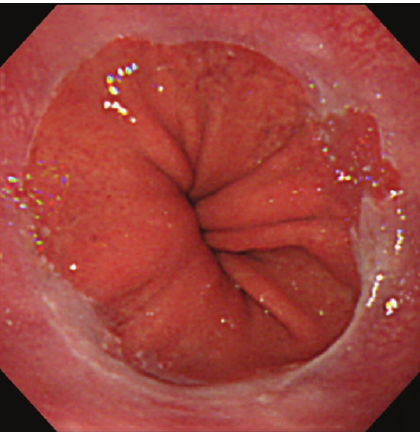
Figure 3: Endoscopic view after 4 weeks of the administration of a proton pump inhibitor. Note the complete disappearance of the